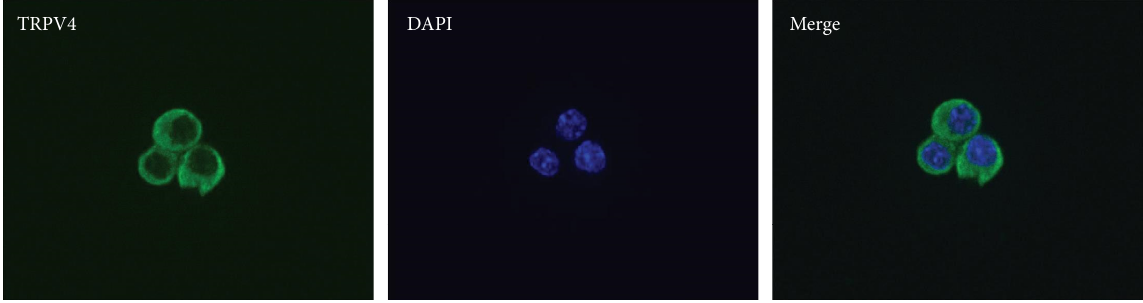
Figure 3: Fluorescence immunostaining of TRPV4 in MGN3-1 cells. TRPV4 protein expression was observed in MGN3-1 cells. Mag- nifcation: × 600. TRPV4-mediated change in [Ca 2+ ] i in MGN3-1 cells.